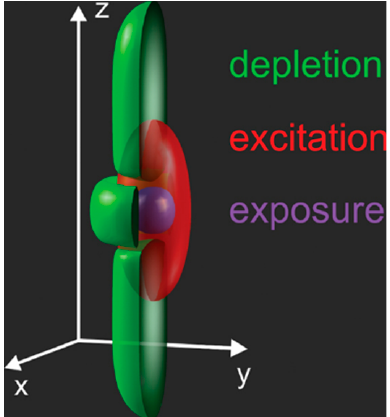
Figure 9. Schematic showing the point spread functions in stimulated emission depletion two-photon lithography [82]. Here the excitation beam is red, depletion beam taking the form of a bottle-beam mode is green, and this yields an effective exposure as shown in purple.